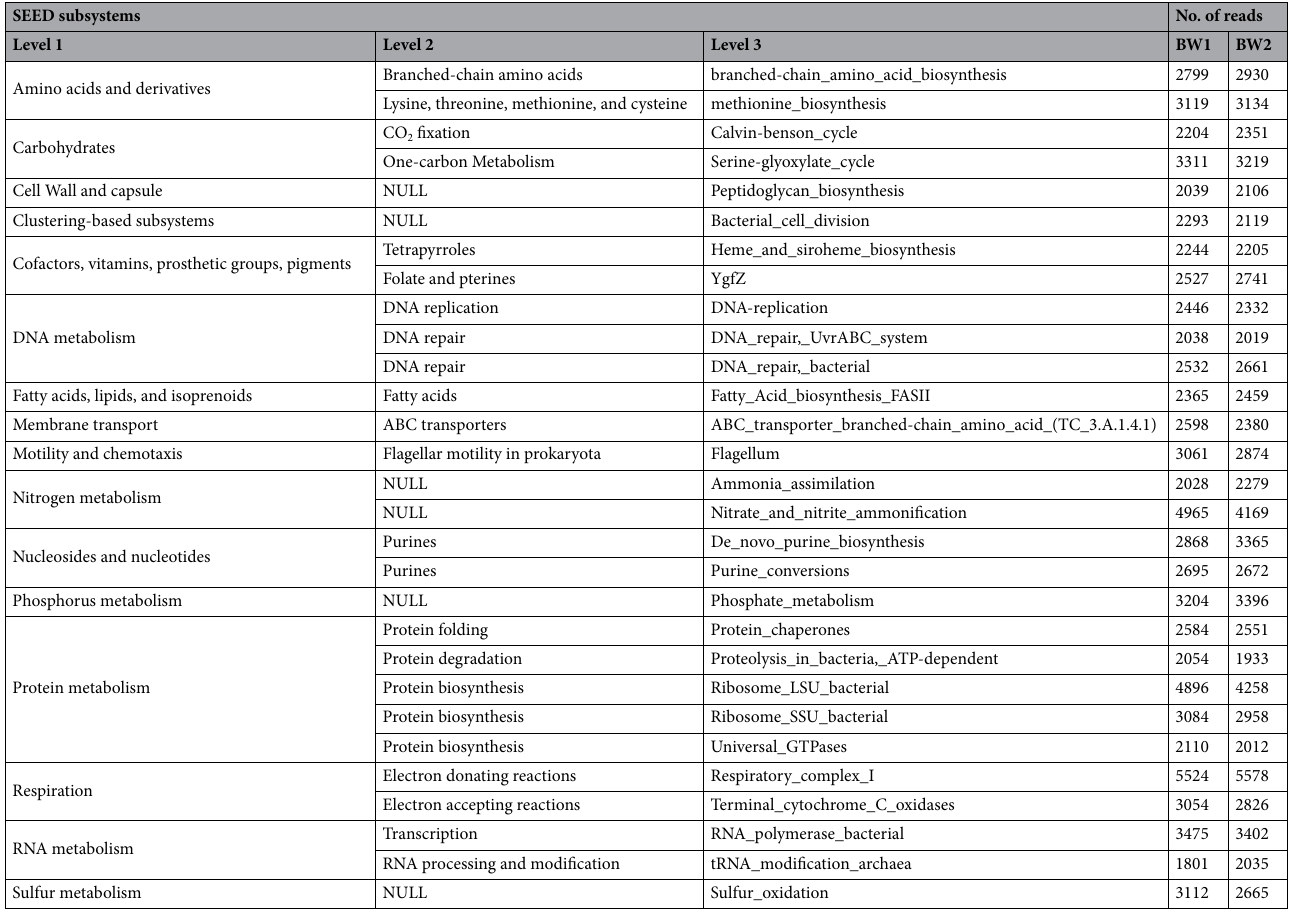
Table 3. Analysis of Subsystems at level 3. From the 28 subsystems at level 3 registered by MG-RAST, only those subsystems with more than 2000 reads assigned were collected in the